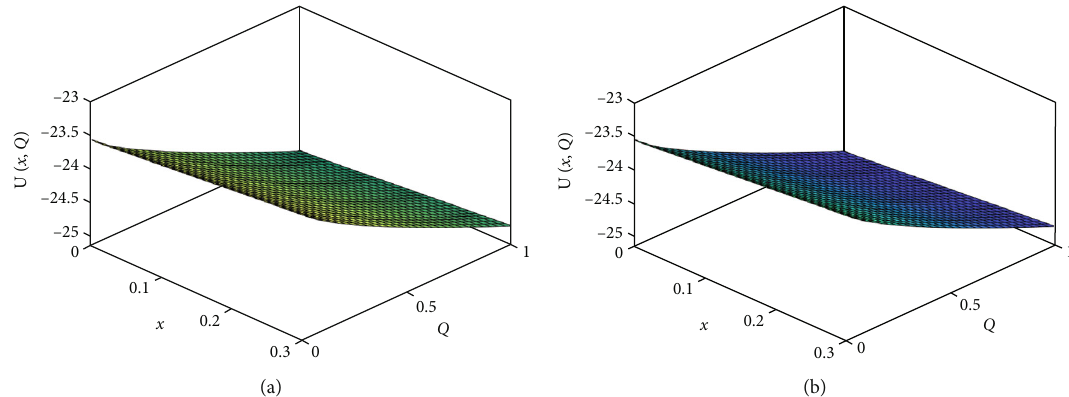
Figure 5: Three-dimensional illustration of the approximate solution via CFD of Example 1 when (a) δ = 0 : 9 and δ = 0 : 8 :